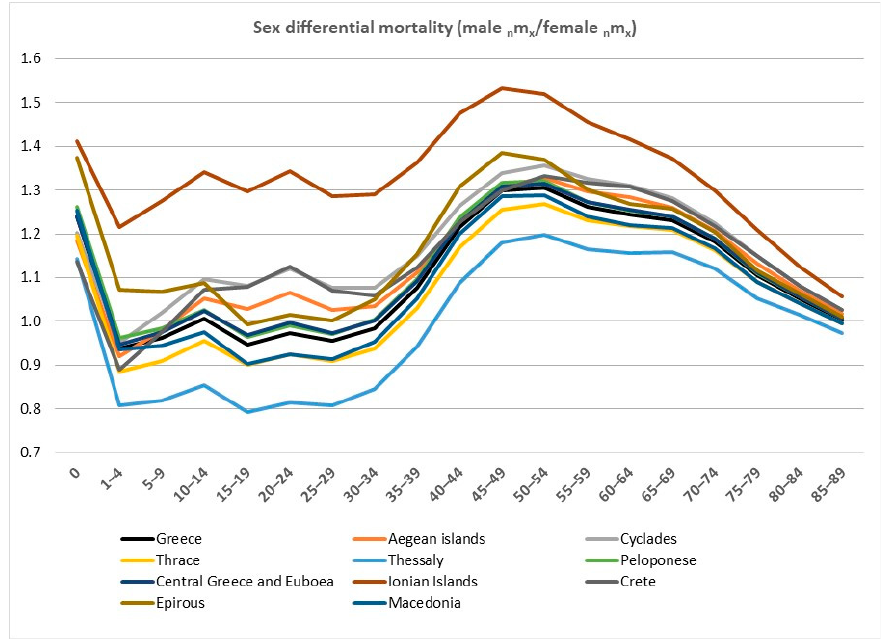
Figure 5. Sex differential mortality in Greece and its ten Geographical Departments in 1928. Source: Life tables in Appendix A.